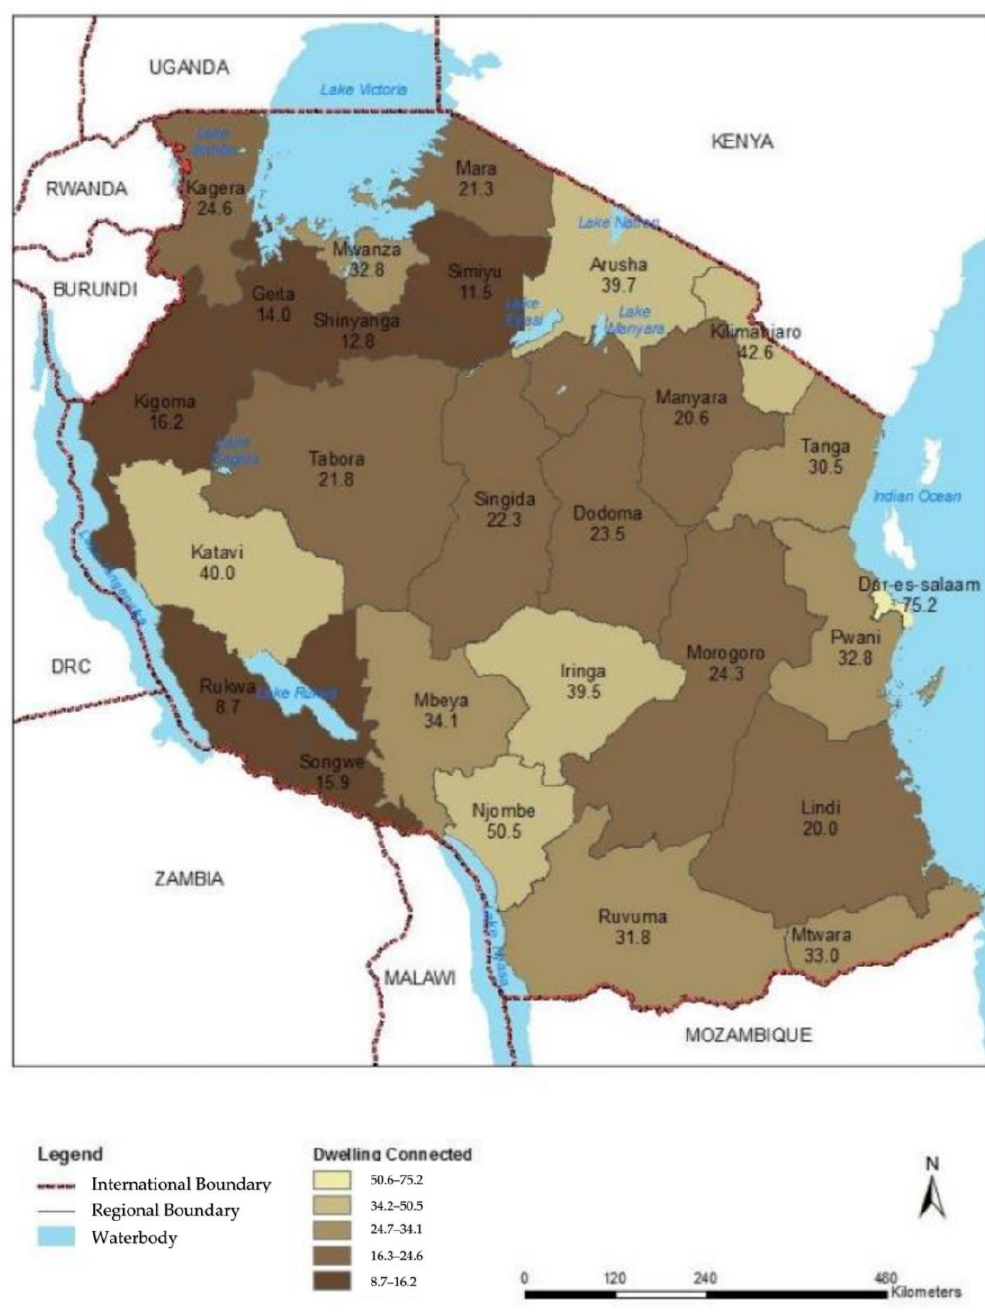
Figure 1. Status of Electricity in Tanzania